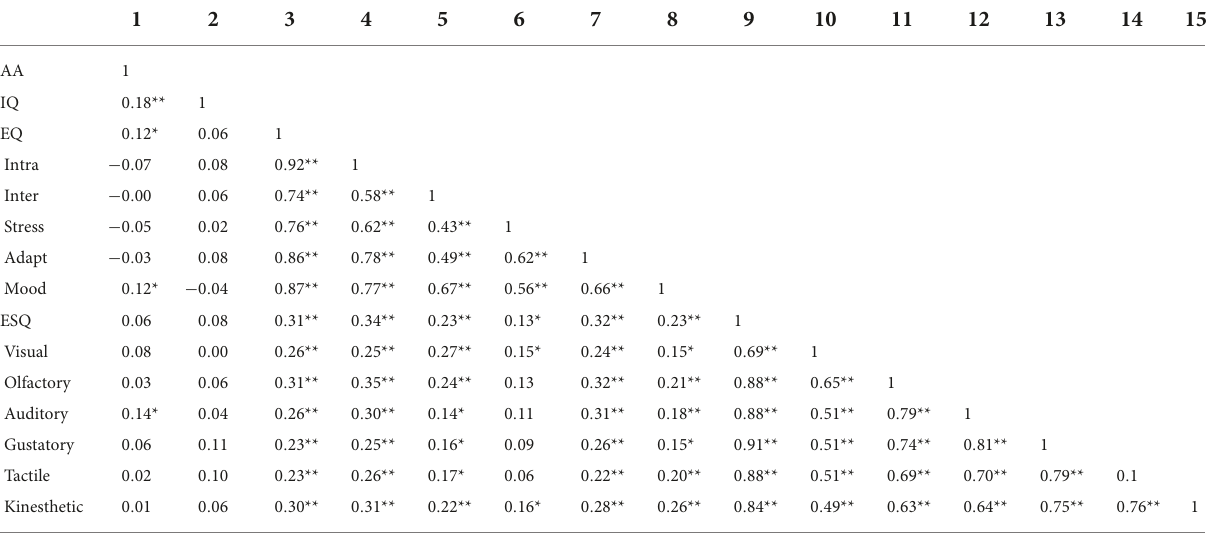
TABLE 2 Correlational analysis for the variables.